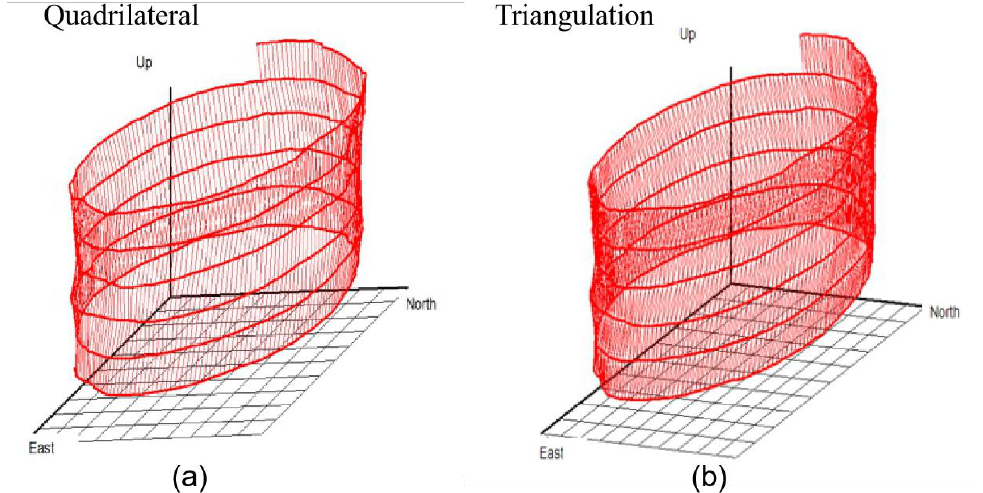
Figure 13. The surface of a wellbore consisting of a quadrilateral (triangle) in space. After the completion of the wellbore quadrilateral, the reconstructed surface quadri- lateral and the depth and angle (sector) of the measured data had unique properties, which corresponded to the gamma and resistivity imaging data that were also obtained while drilling. The quadrilateral was colored based on the corresponding relation by using the imaging measurement chromatography to form a relatively intuitive color wellbore spatial structure, as show in Figure 14.